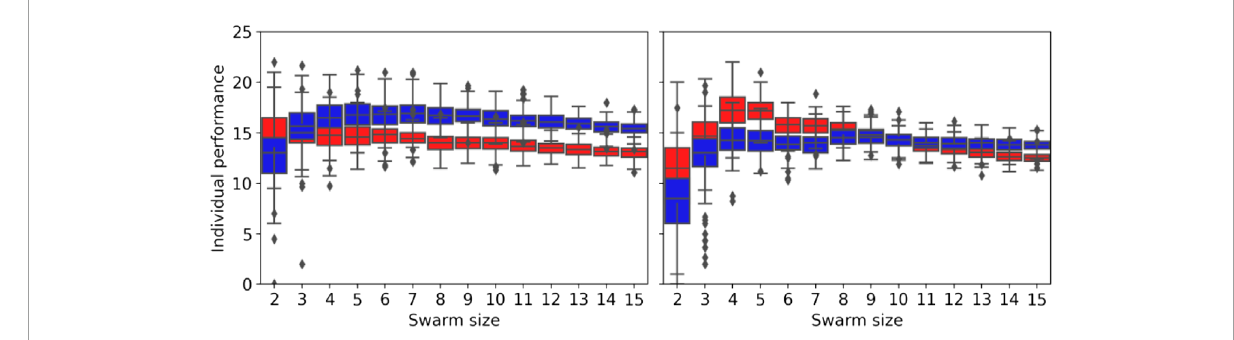
FIGURE 16 Individual performance for different swarm sizes for the homogeneous error (left) and heterogeneous error (right) for the NPS in red and the DPS in blue. The individual performance decreases after the first robot for the NPS and after seven robots for the DPS with the homogeneous error. The individual performance peaks at four robots for the NPS and at eight robots with the DPS for the heterogeneous error.